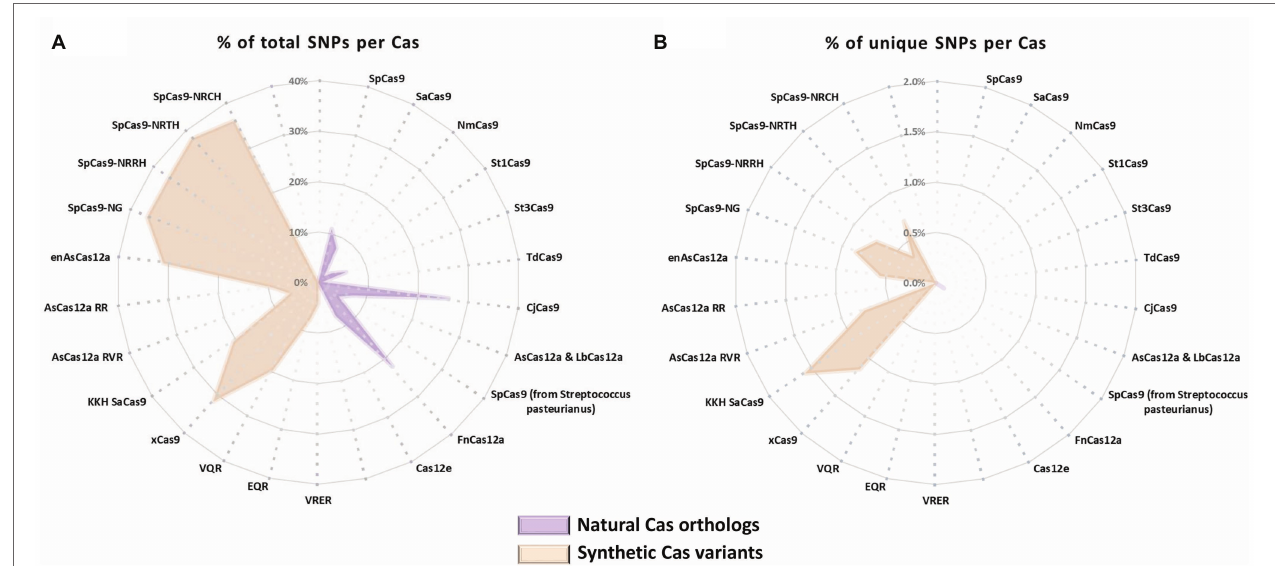
FIGURE 2 | SNPs matching coverage comparison by Cas. Cas natural orthologs (purple) and synthetic variants (orange) representation of (A) total matching SNPs for each Cas (% out of total SNPs) and (B) exclusive matches of SNPs for each Cas variant (% out of total